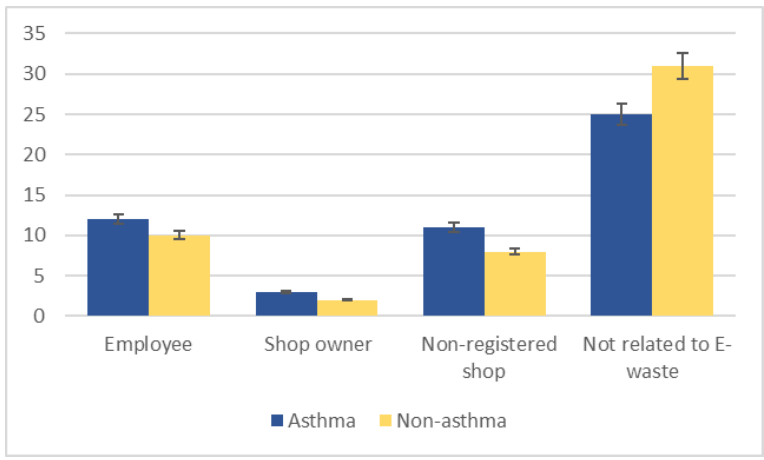
Figure 2. Participant involvement in electronic waste (e-waste) activities, stratified by asthma status.